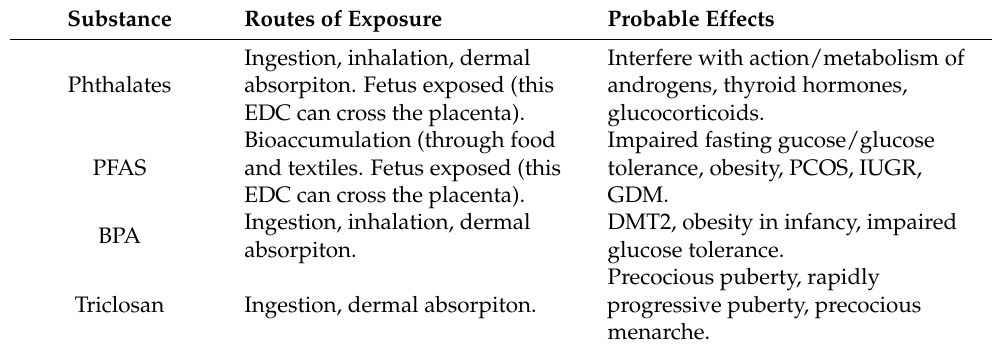
Interfere with action/metabolism of androgens, thyroid hormones, glucocorticoids. Impaired fasting gucose/glucose tolerance, obesity, PCOS, IUGR, GDM. DMT2, obesity in infancy, impaired glucose tolerance. Precocious puberty, rapidly progressive puberty, precocious